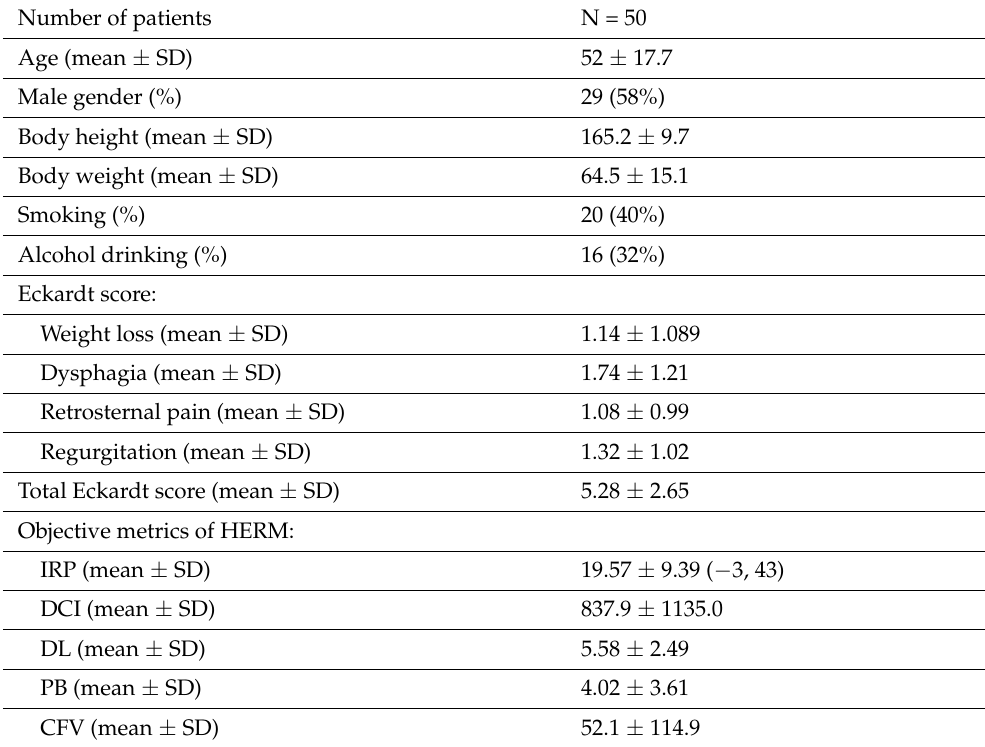
Table 1. Demographics, clinical characteristics of the study subjects, and surgical intervention rates of patients with non-spastic motility disorders.